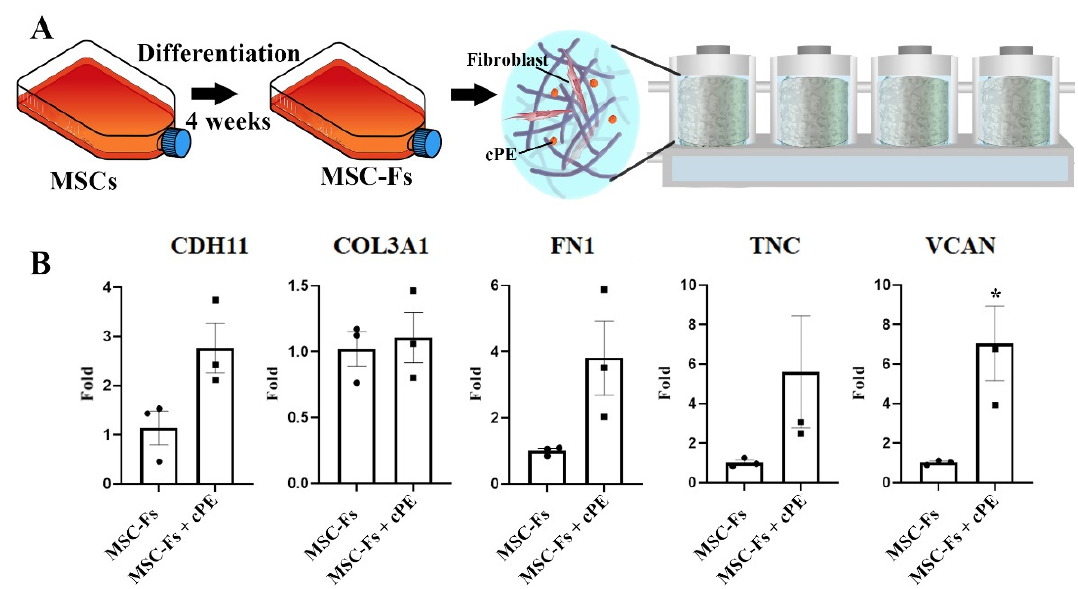
Figure 1. cPE induces the expression of functional fibroblast markers in MSC-Fs. ( A ) Experimental setup. MSC-Fs were seeded inside a 3D scaffold with or without polyethylene particles. ( B ) qPCR revealed an increased gene expression of fibroblast marker genes in MSC-Fs upon exposure to cPE, with a significant difference for VCAN . (* p < 0.05) (values are ± standard error of the mean (SEM)).